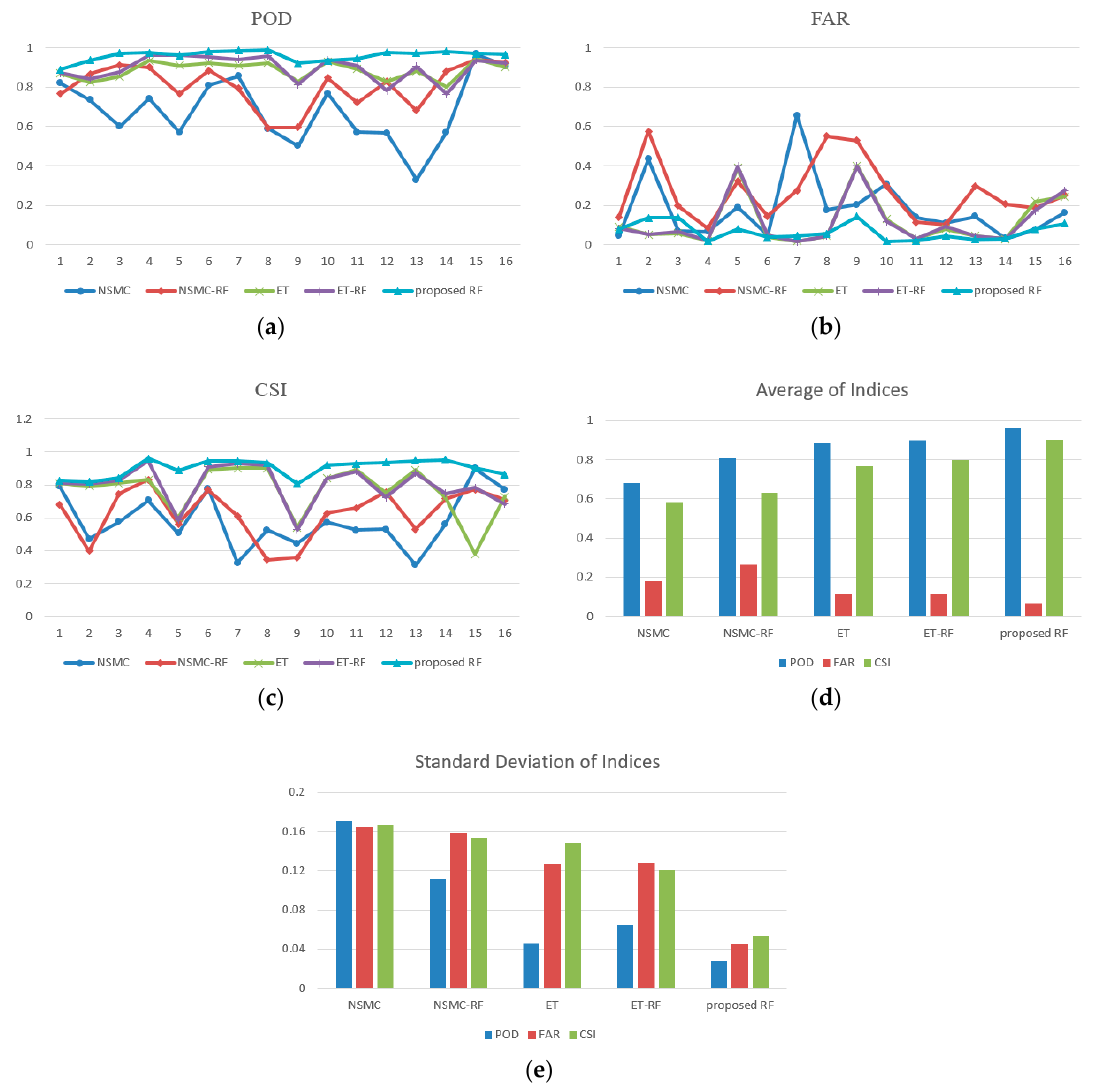
Figure 16. The objective evaluation results. ( a ) Probability of Detection (POD); ( b ) False Alarm Ratio (FAR); ( c ) Critical Success Index (CSI); ( d ) Average of indices; ( e ) Standard deviation of indices.